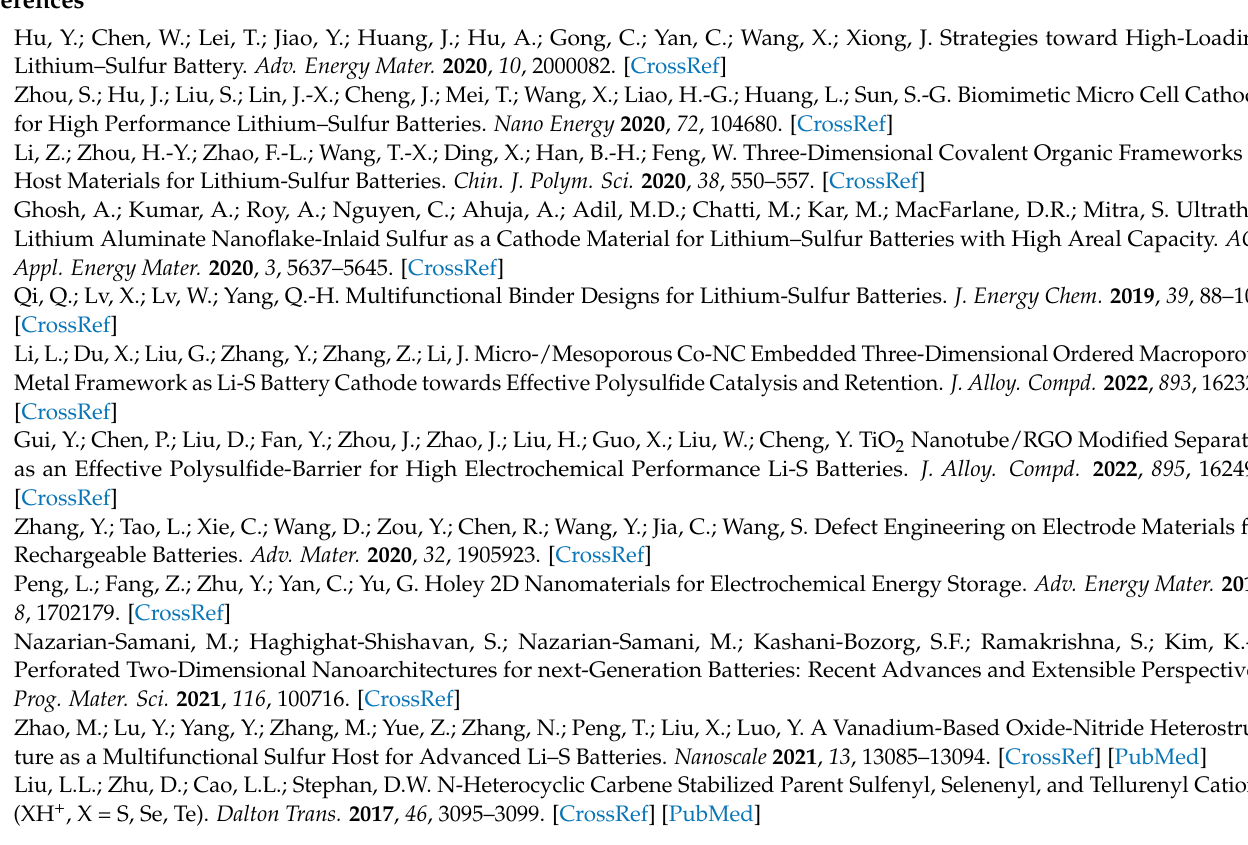
Figure S1. (a,b) SEM image of unoxidized niobium flakes; (c,d) AFM diagram of unoxidized niobium flakes; Figure S2. (a–c) SEM image of porous niobium oxide after sulphury mixing; (d–g) SEM images and elemental mapping images of P-Nb 2 O 5 after sulphury mixing. Nb, O and S are represented in green, red and yellow, respectively; Figure S3. (a–c) SEM image of P-Nb 2 O 5 electrode after cycling; Figure S4. XRD patterns of P-Nb 2 O 5 and G-Nb 2 O 5 after sulphury mixing; Figure S5. (a,b) SEM image of G-Nb 2 O 5